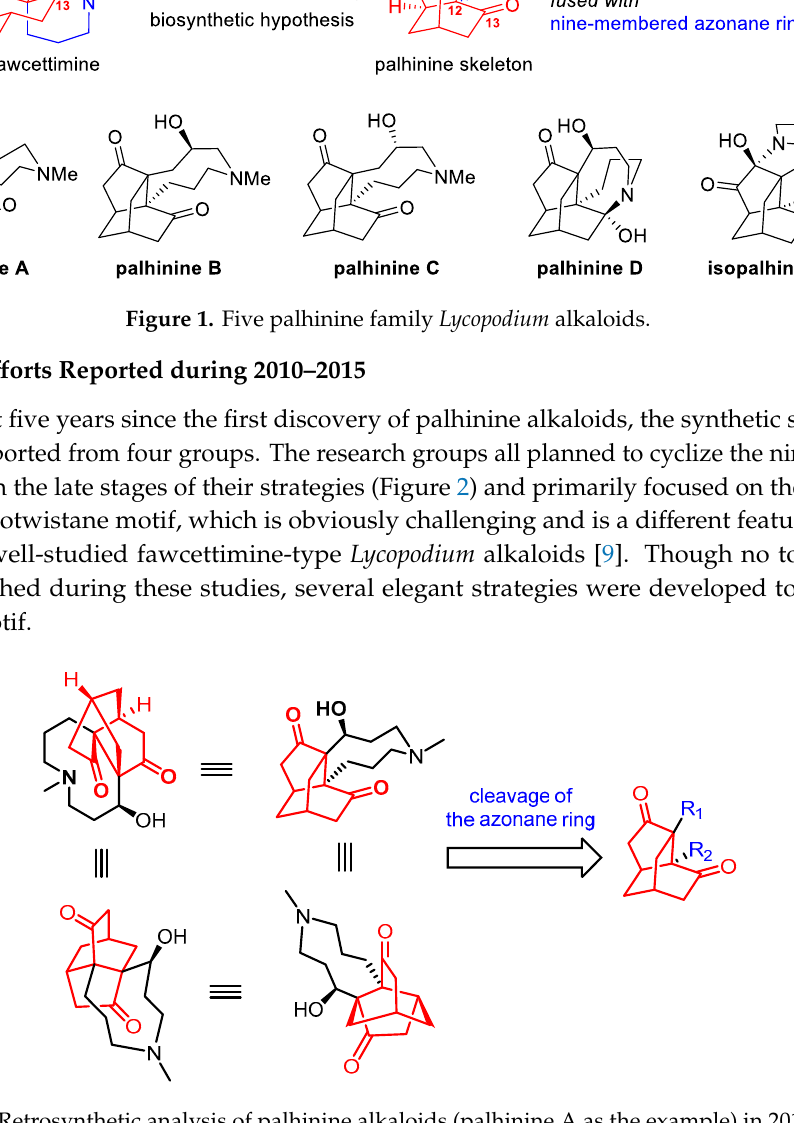
Figure 2. Retrosynthetic analysis of palhinine alkaloids (palhinine A as the example) in 2010–2015.